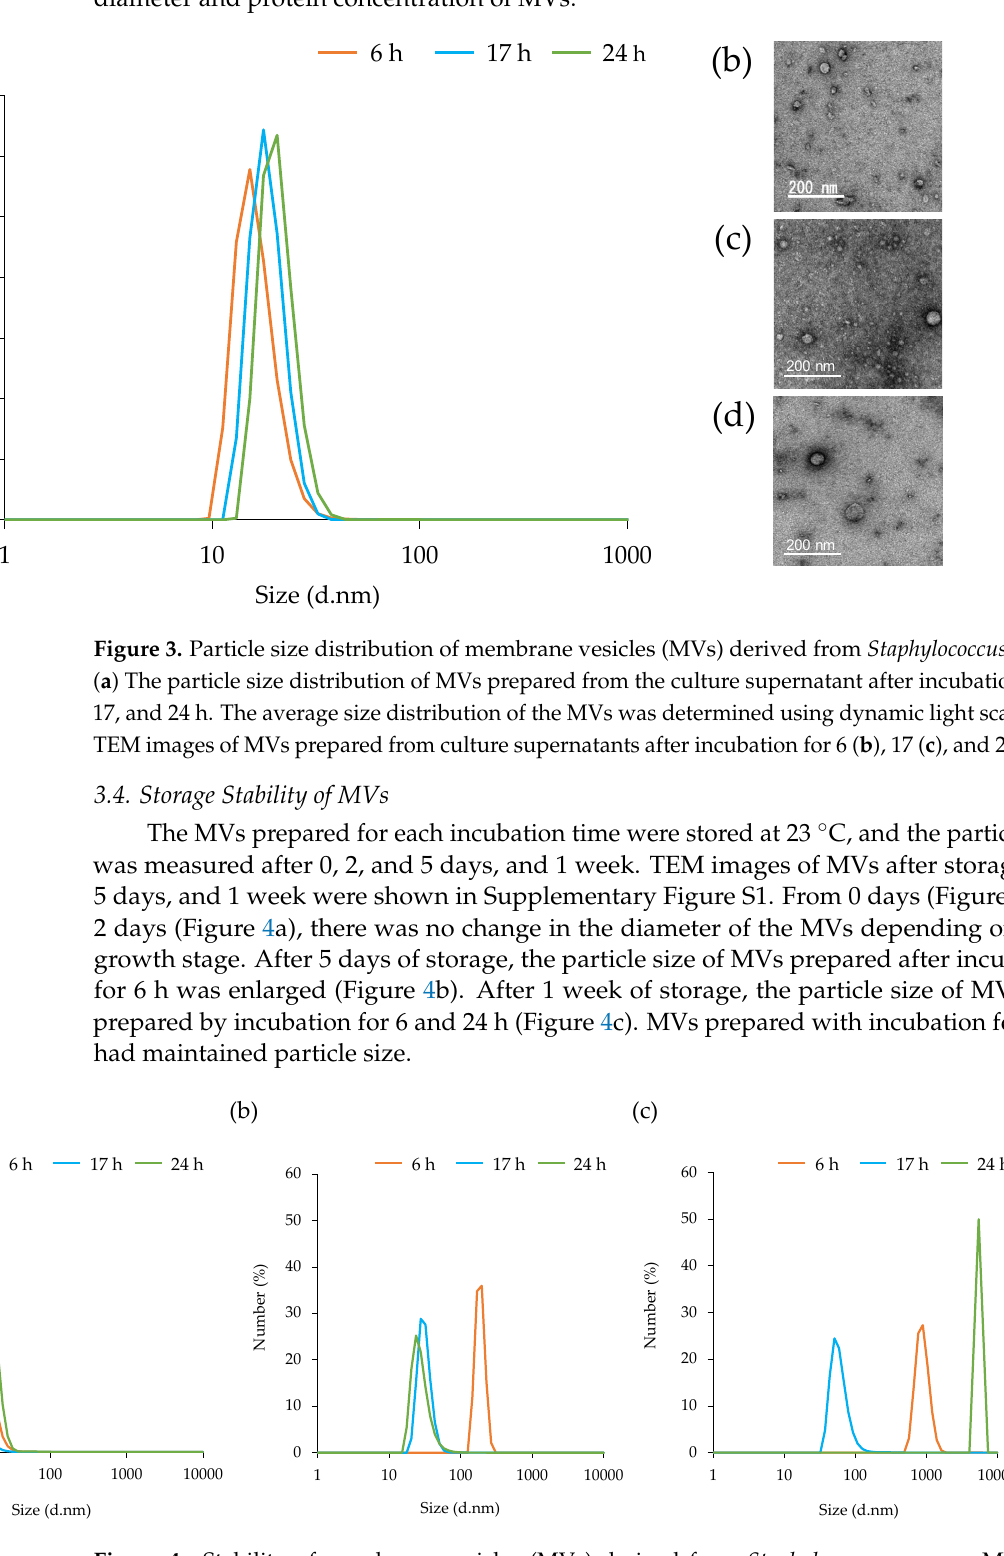
17, and 24 h, respectively. In summary, the incubation time did not affect the morphology, diameter and protein concentration of MVs.